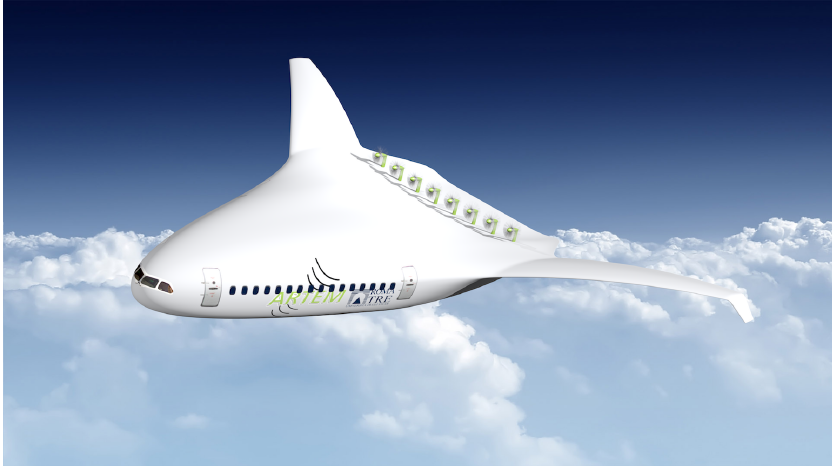
Figure 1. Pictorial rendering of the HEP regional BWB